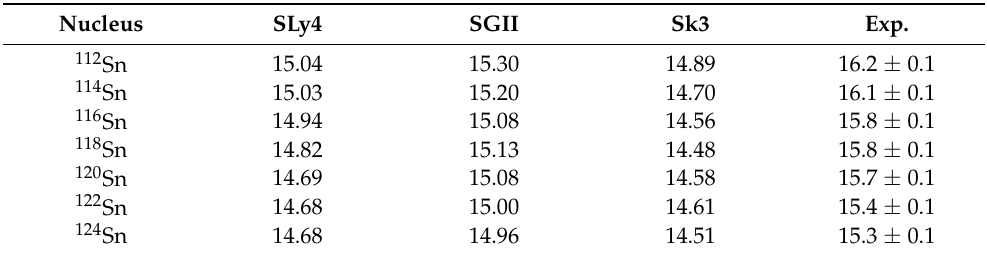
Table 2. The values of the centroid energies E ISGMR (in MeV) of Sn isotopes ( A = 112–124) obtained from HF+CDFM calculations in this work using SLy4, SGII, and Sk3 Skyrme forces. The experimental data are taken from Table III of Ref. [59].